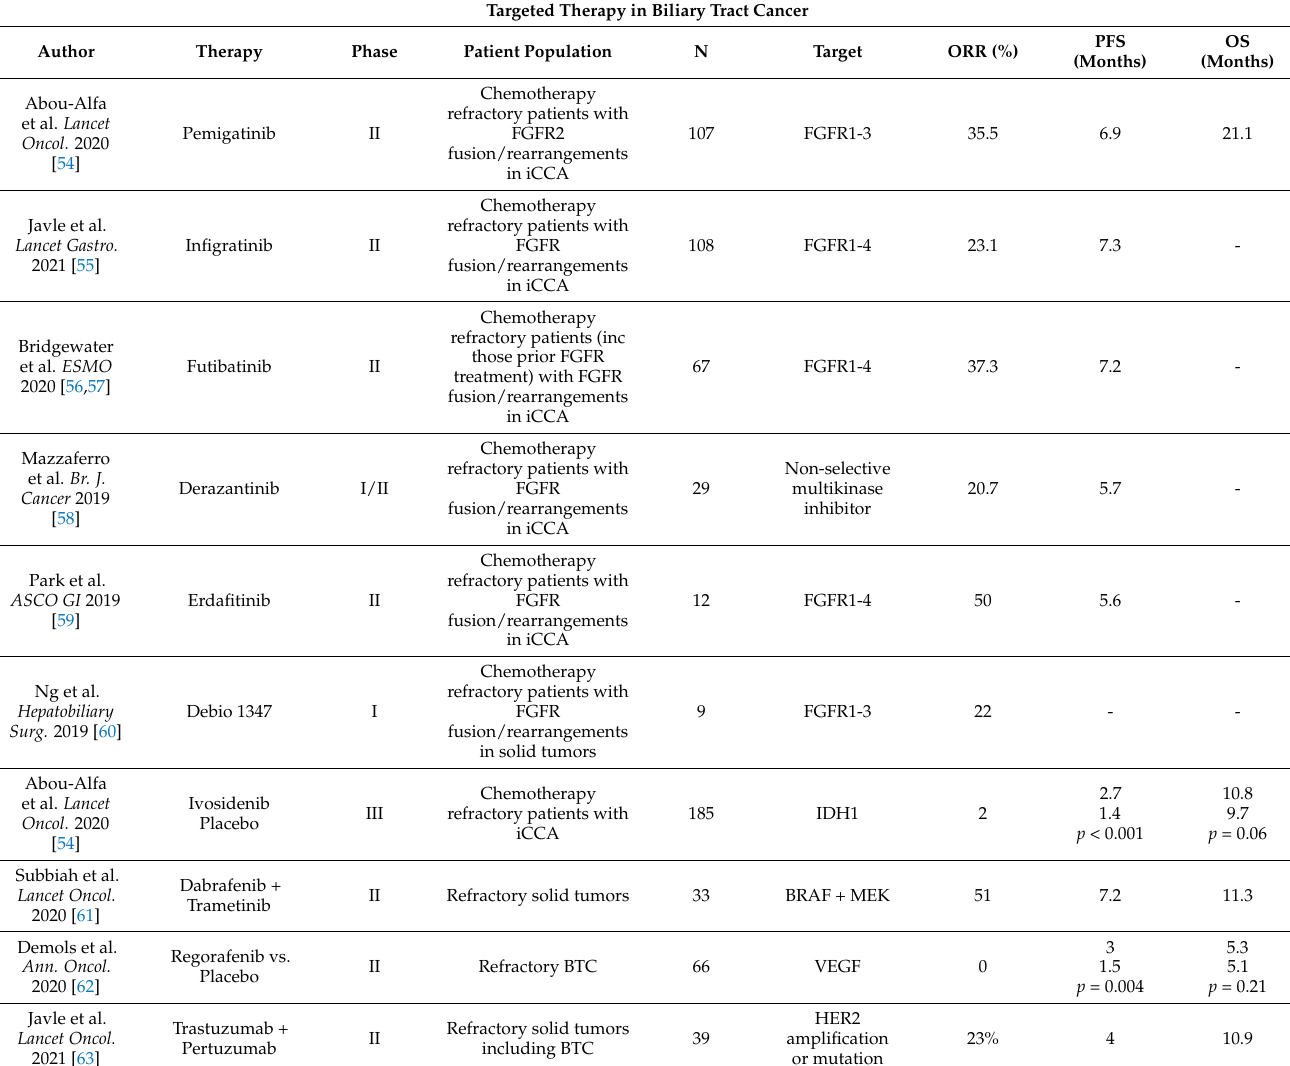
Table 2. Targeted therapy in biliary tract